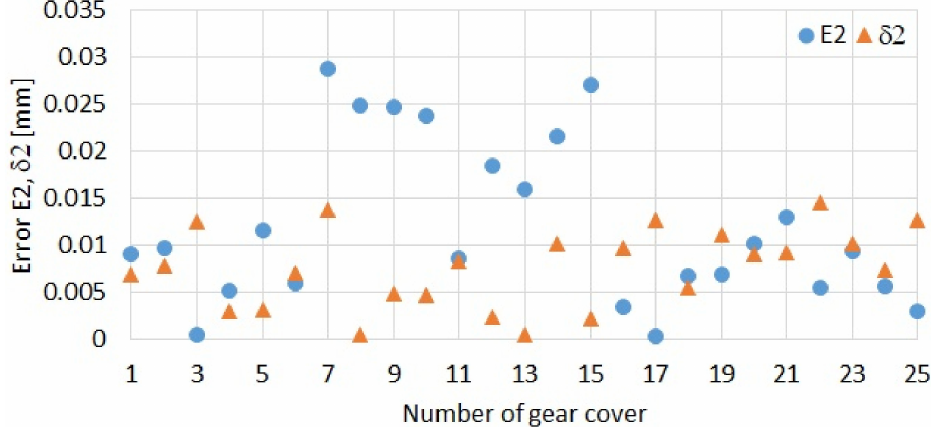
Figure 14. Summary of errors δ 2 and E 2 for the data from the test set for bearing seat 2.